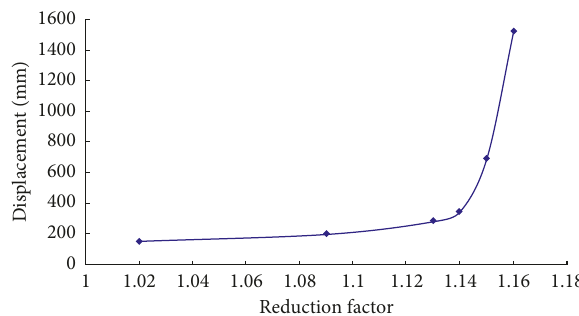
Figure 14: Horizontal deformation rate at the 300 th day with a key point of 5 under different reduction